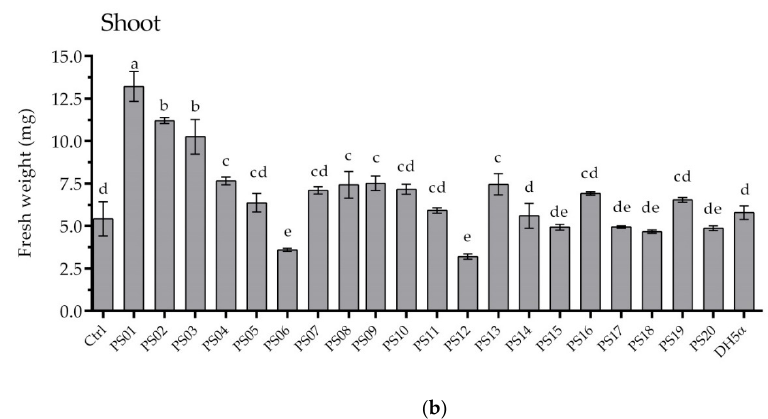
Figure 1. Screening of effective plant growth-promoting rhizobacteria ( PGPR ) strains using plant growth assay. Root ( a ) and shoot ( b ) fresh weight of Arabidopsis seedlings measured after 12 days of co-cultivation. Pseudomonas isolates were code as PS01–PS20. E.coli DH5 strain was used as bacterial control. The bars represent mean fresh weights ± SD ( n = 15). Experiments were repeated at least 3 times with similar results. Different letters indicate statistically significant differences (Tukey’s HSD test; p <0.05).